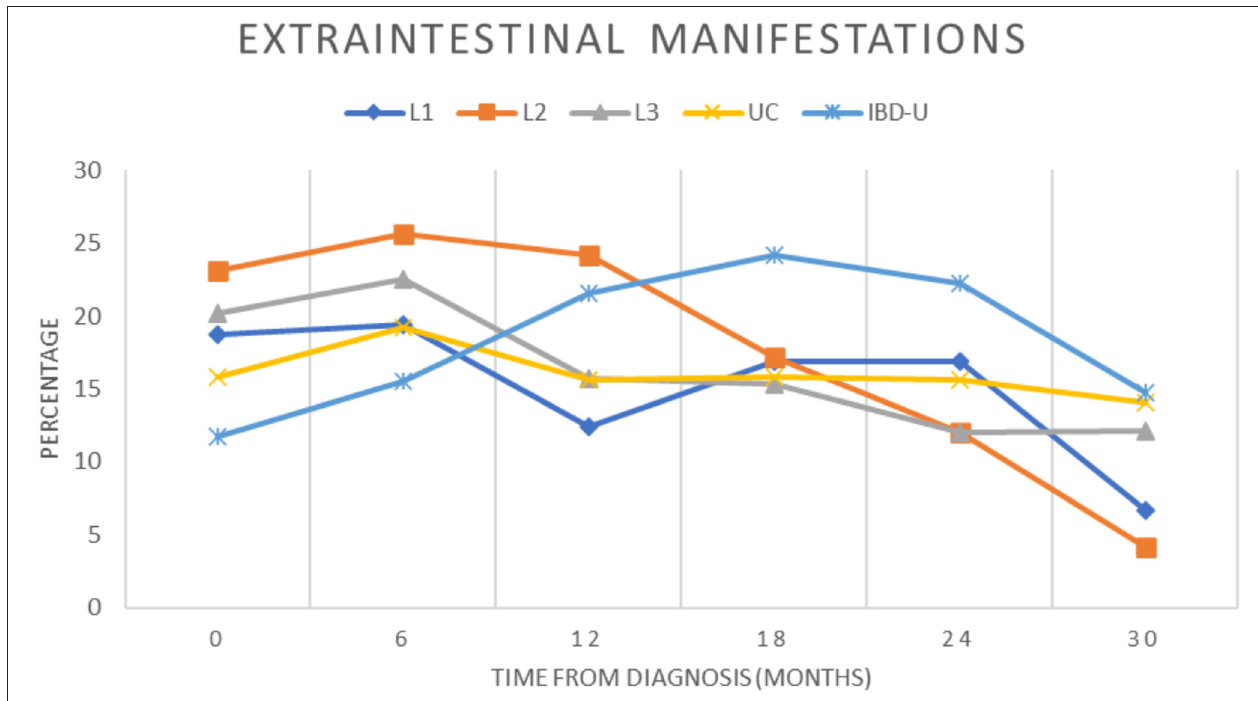
FIGURE 1 | Presence of extraintestinal manifestations during the course of disease. The proportion of patients in the cohort with extraintestinal manifestations were recorded over a 2.5-year period for each subgroup and indicated from diagnosis (0) and for every 6 months ( ± 3 months) of follow-up (L1, blue diamond; L2, orange square; L3, gray triangle; UC, yellow cross; IBD-U, light blue